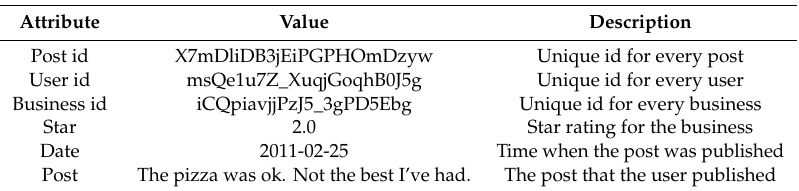
Table 1. An example of a post on